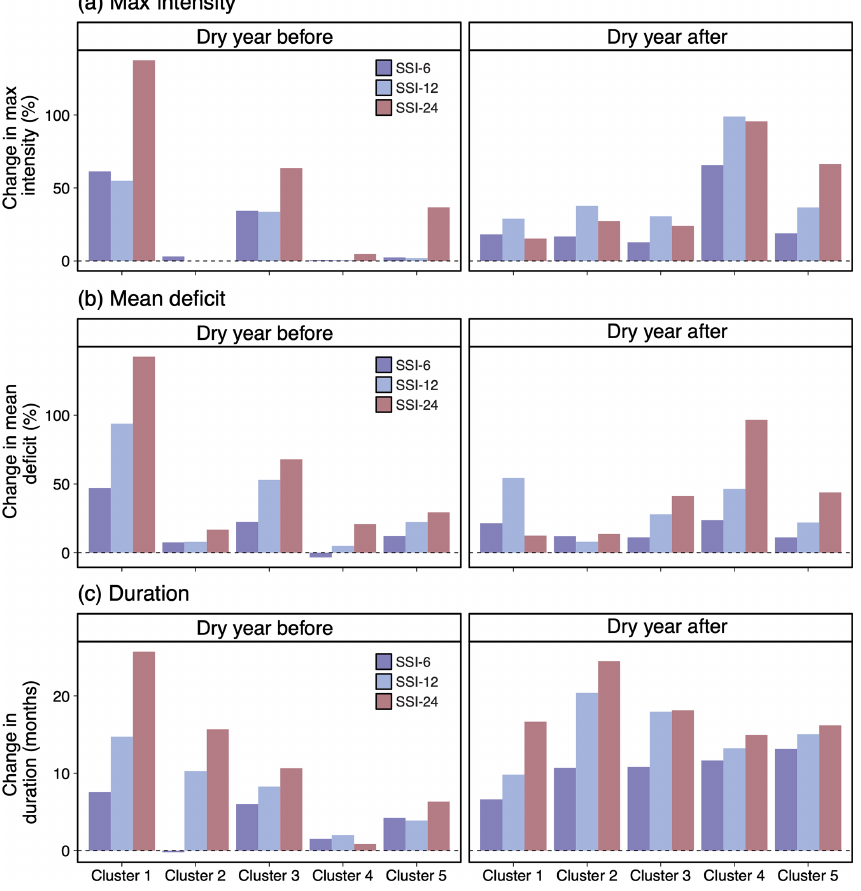
Figure 8. Mean change in the (a) max drought intensity (%), (b) mean drought deficit (%), and (c) duration (months) relative to the baseline for each cluster for the repetition of a dry year (2010) either before (left) and after (right) the 2010–2012